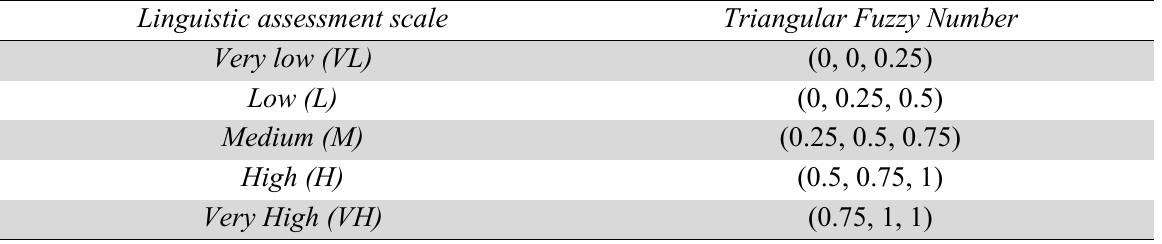
Linguistic scale to evaluate the ratings of alternatives (Chang, 1996) Linguistic assessment